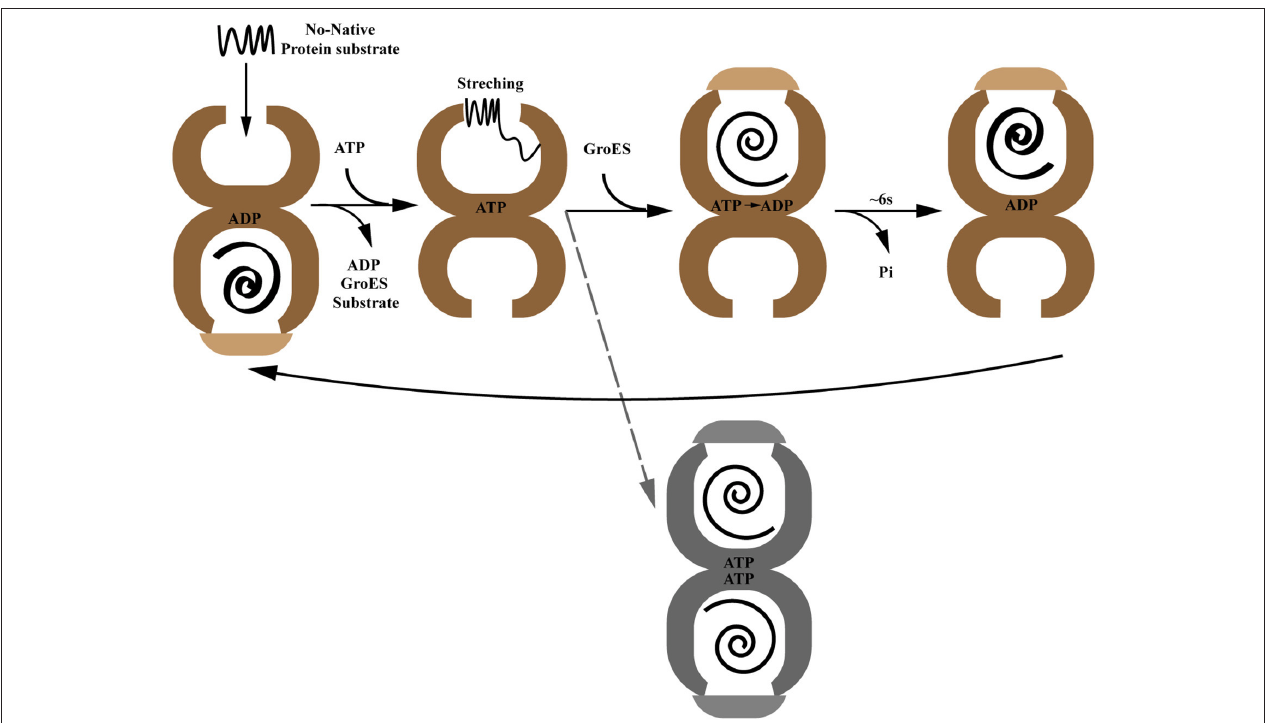
FIGURE 1 | The paradigmatic chaperonin GroES/GroEL reaction cycle. The gray dotted line indicates the controversial GroEL/(GroES)2 folding active intermediate.